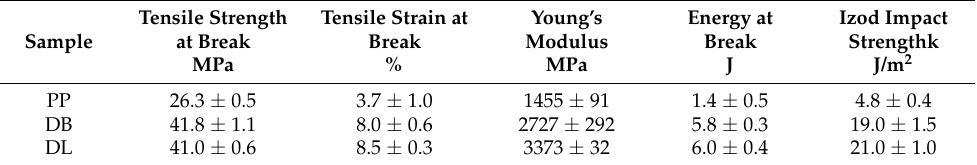
Table 6. Mechanical properties of PP and PP hybrid composites obtained with the selected masterbatches.